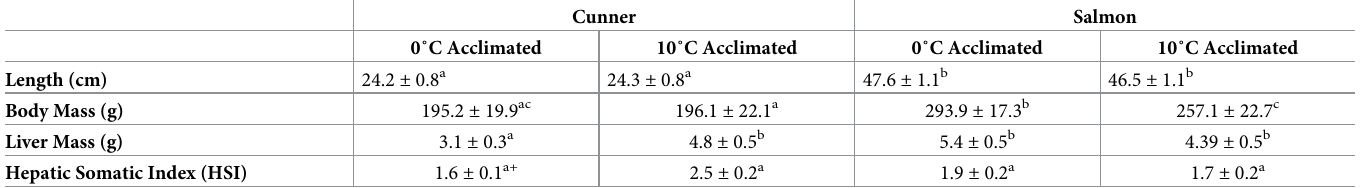
Table 1. Morphometric parameters measured in 0 and 10˚C acclimated cunner and salmon. Letters indicate a significant difference between groups, whereas a plus sign ( + ) indicates a significant acclimation effect (P < 0.05) as determined by 2-way ANOVA. Values are means ± s.e.m., N =